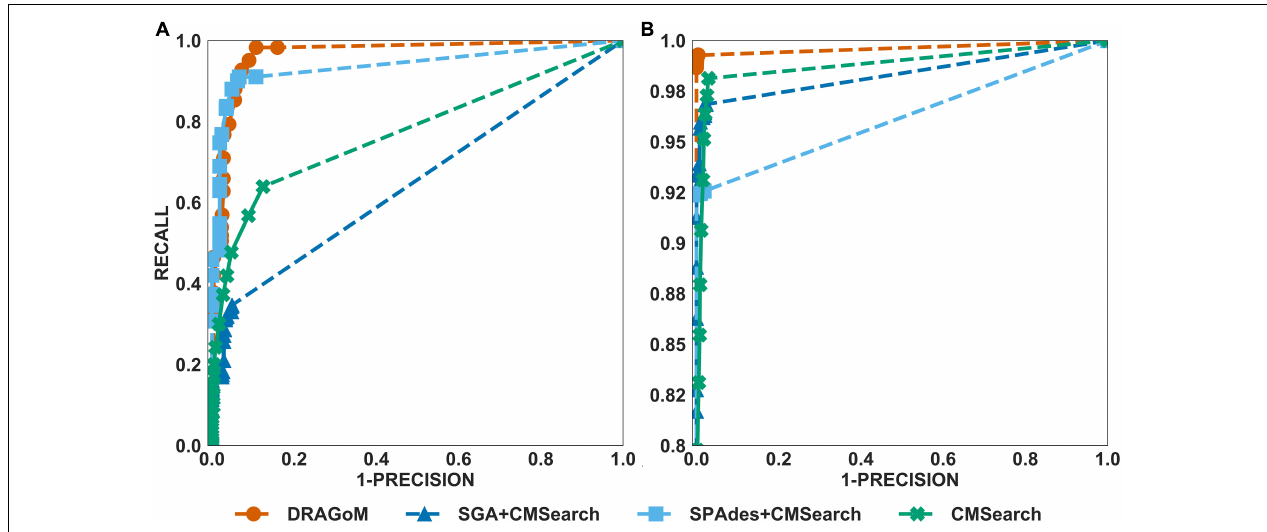
FIGURE 2 | The ROC curves for searching (A) 42 non-16S rRNAncRNA families and (B) 16S rRNAs using the corresponding programs against DS1 (the REAGO dataset).